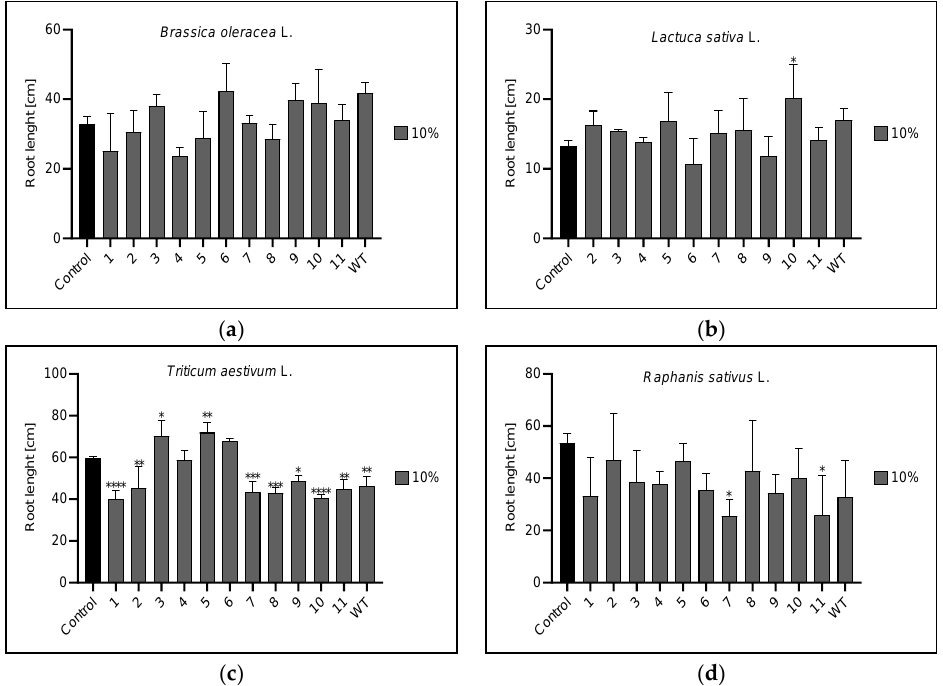
Figure 7. Root length of broccoli ( a ), lettuce ( b ), wheat ( c ), and radish ( d ) sprouts treated with 10% concentration for all tested algae clones (1-11, WT) and control (Control). Values represent mean ± SD, n = 10 plants, * p < 0.1, ** p < 0.01, *** p < 0.001, **** p < 0.0001 compared to control (ANOVA and Dunnett ’ s a posteriori test).